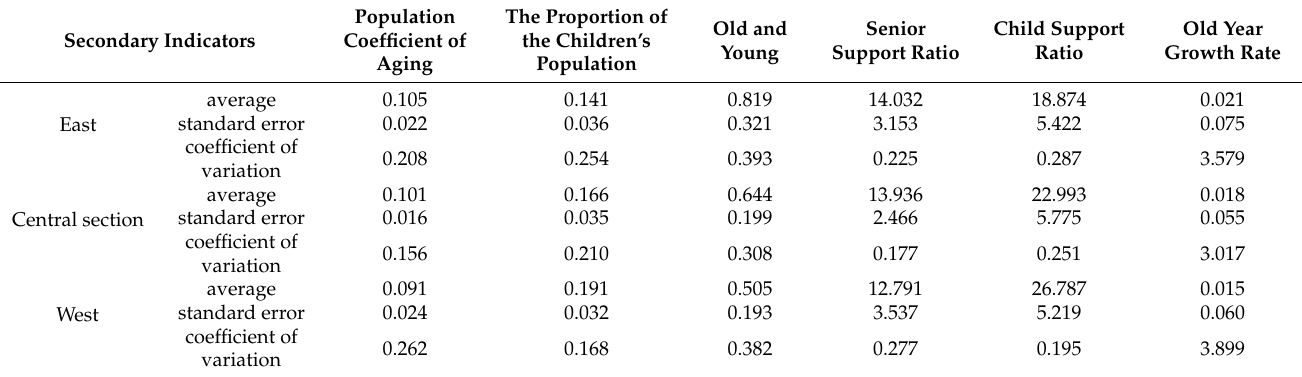
Table 5. Differences in population aging indicators in the various regions.